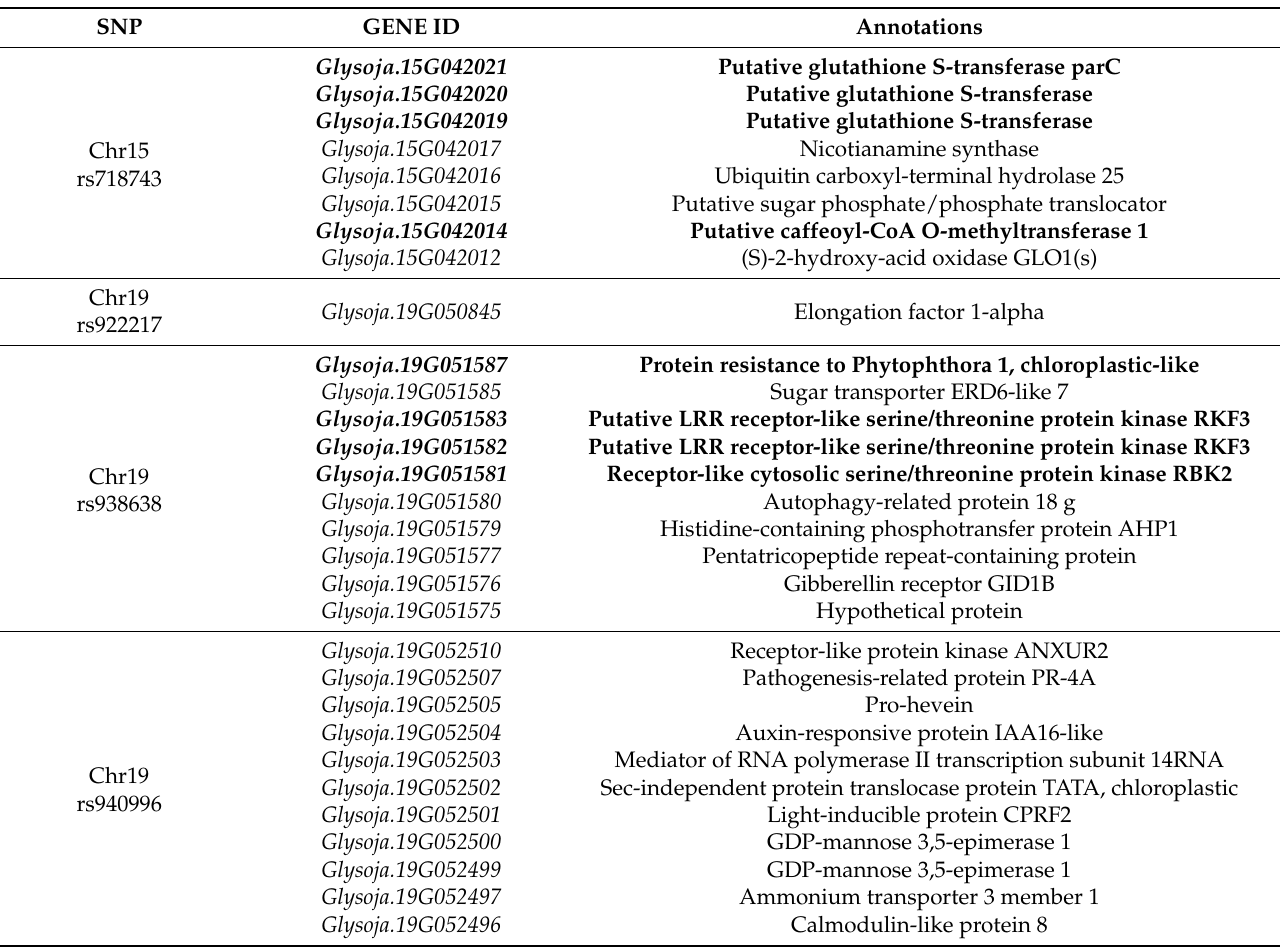
Table 7. Prediction of candidate genes.